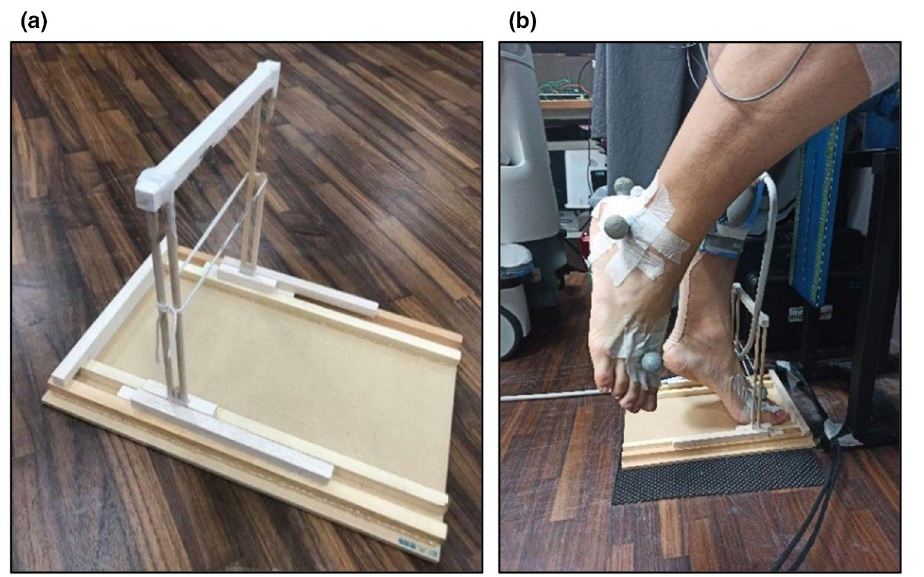
Figure 3. Custom-built Haberometer ( a ) and single heel rise ( b